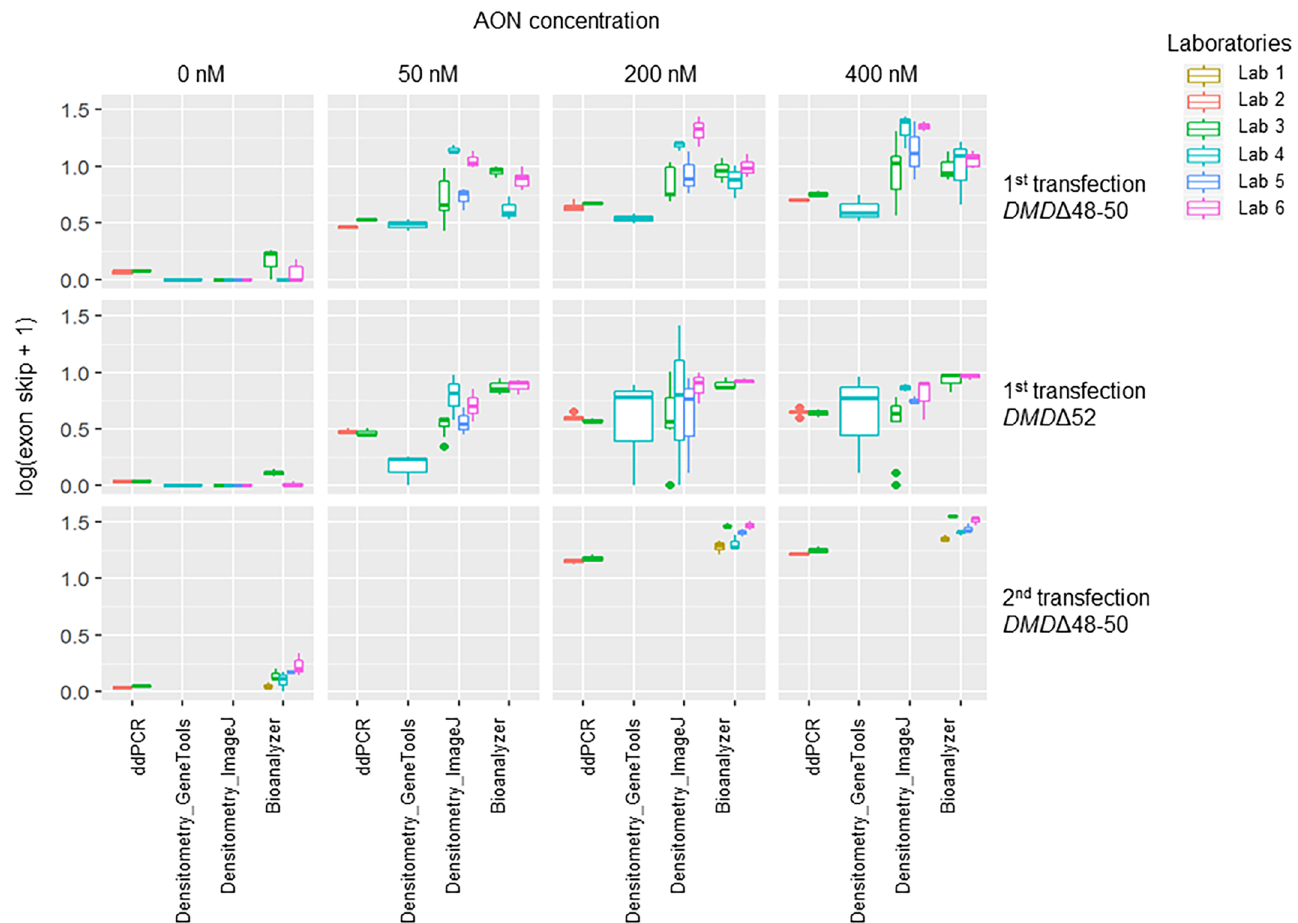
Fig 4. Boxplots of log transformed exon skipping levels (y-axis) are shown per technology (x-axis). The figure is divided into three horizontal panels representing the different sets of samples and four vertical panels illustrating the AON concentrations used for the transfections. Exon skipping levels of the different labs are shown in colours (lab 1 = yellow, lab 2 = red, lab 3 = green, lab 4 = turquoise, lab 5 = blue and lab 6 = pink). Outliers are represented by coloured